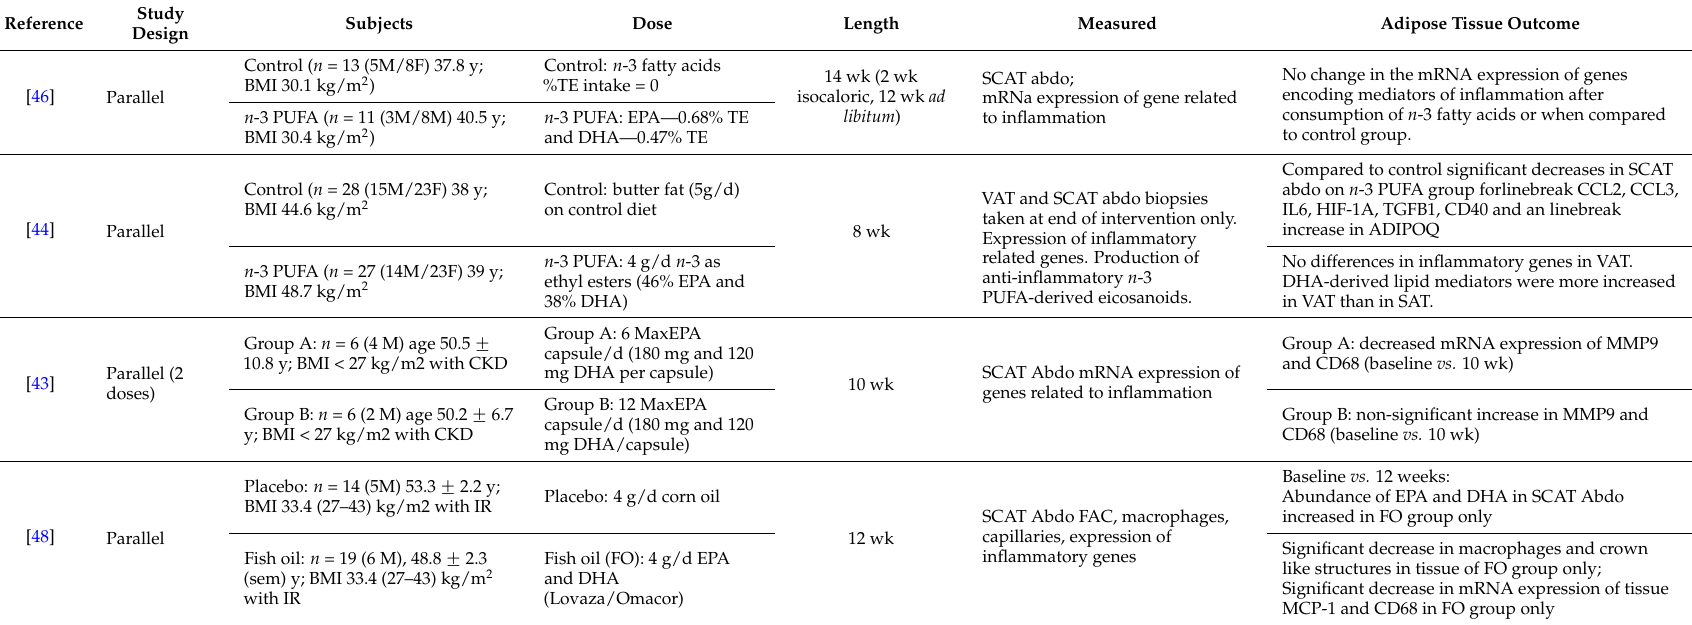
Significant decrease in macrophages and crown like structures in tissue of FO group only; Significant decrease in mRNA expression of tissue MCP-1 and CD68 in FO group